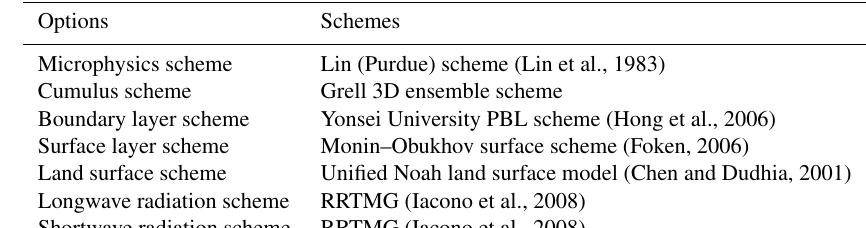
Table 1. Physical parameterization options used in the simulation.